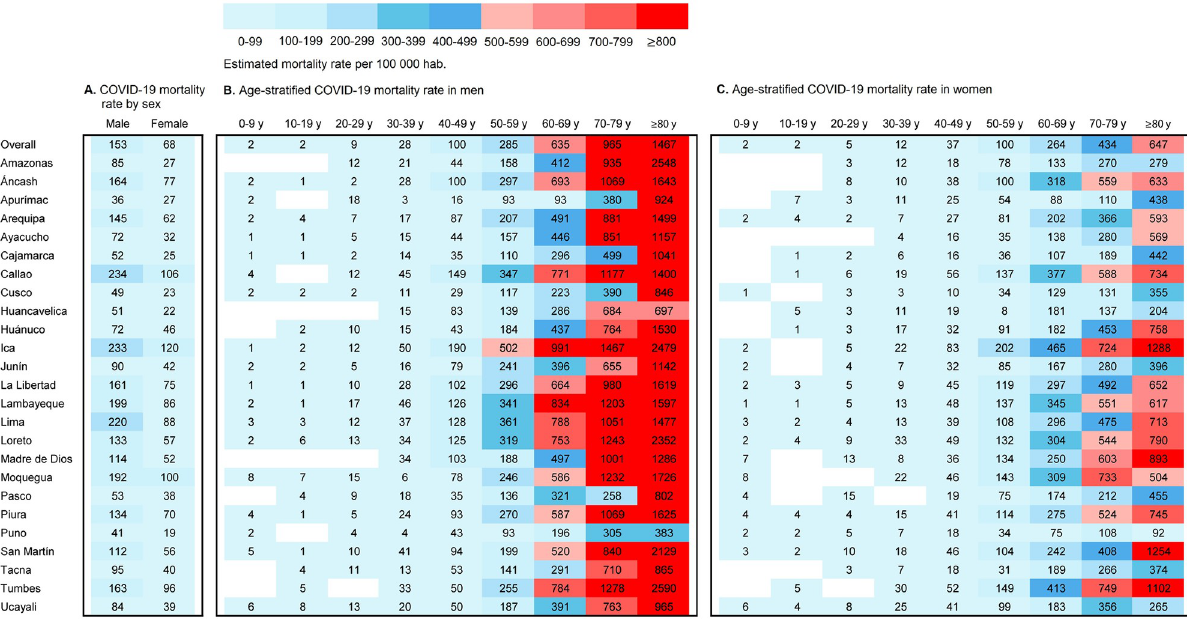
PLOS ONE | https://doi.org/10.1371/journal.pone.0253193 June 14,